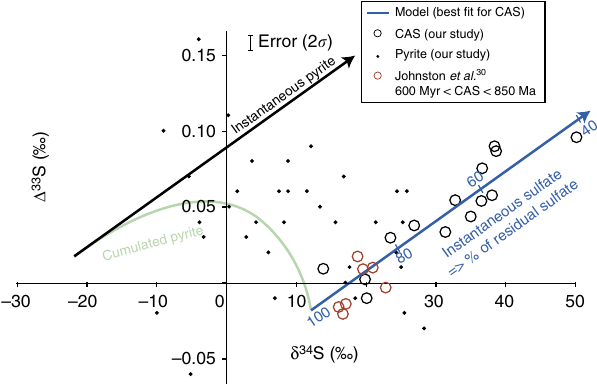
Figure 2 | Multi-isotopic cross-plot and model results. D 33 S versus d 34 S diagrams, best-fit line for CAS is obtained using the following parameters for the model: 34 a sulfide-sulfate ¼ 0.960, 33 b ¼ 0.5125 and F in / F out ¼ 0.3. The blue line corresponds to the evolution of the isotopic composition of the residual sulfate during a distillation. The black and green lines correspond to the isotopic evolution of the instantaneous and cumulative pyrite,